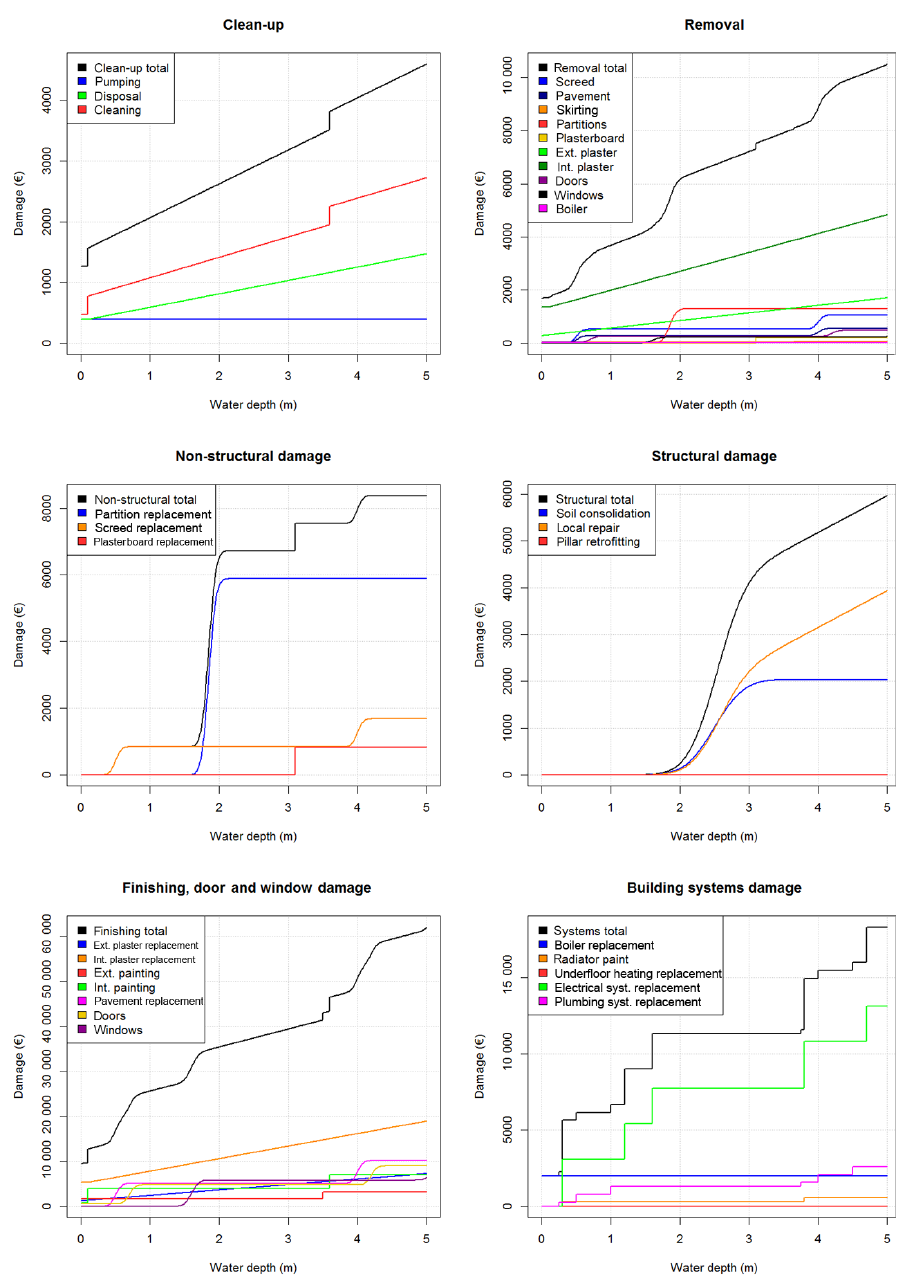
Figure 2. Example of INSYDE damage functions for all building subcomponents, considering the following event variables: flow velocity = 2.0ms − 1 , flood duration = 24h, sediment concentration = 0.05, and water quality = presence of pollutants. Table 4. Comparison of loss estimates produced by INSYDE and other models in literature. Debo Dutta et al. FLEMOps Oliveri and Santoro Luino et